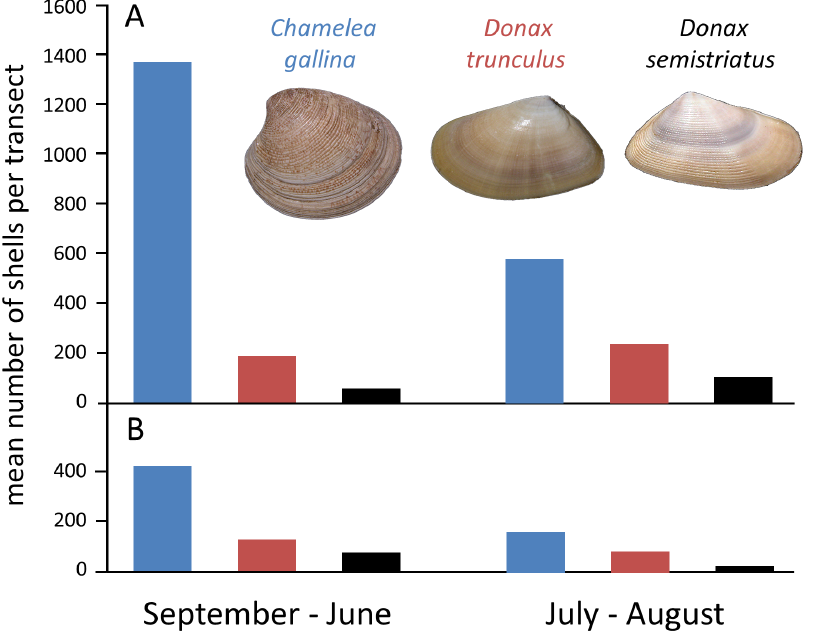
Figure 4. Rank abundance of shells of the three dominant species grouped by tourist seasons for the 1978–1981 and 2008–2010 sampling intervals. Values averaged across all transects conducted during a given time interval and season. (a) Data for 1978–1981 transects; (b) Data for 2008–2010 transects.